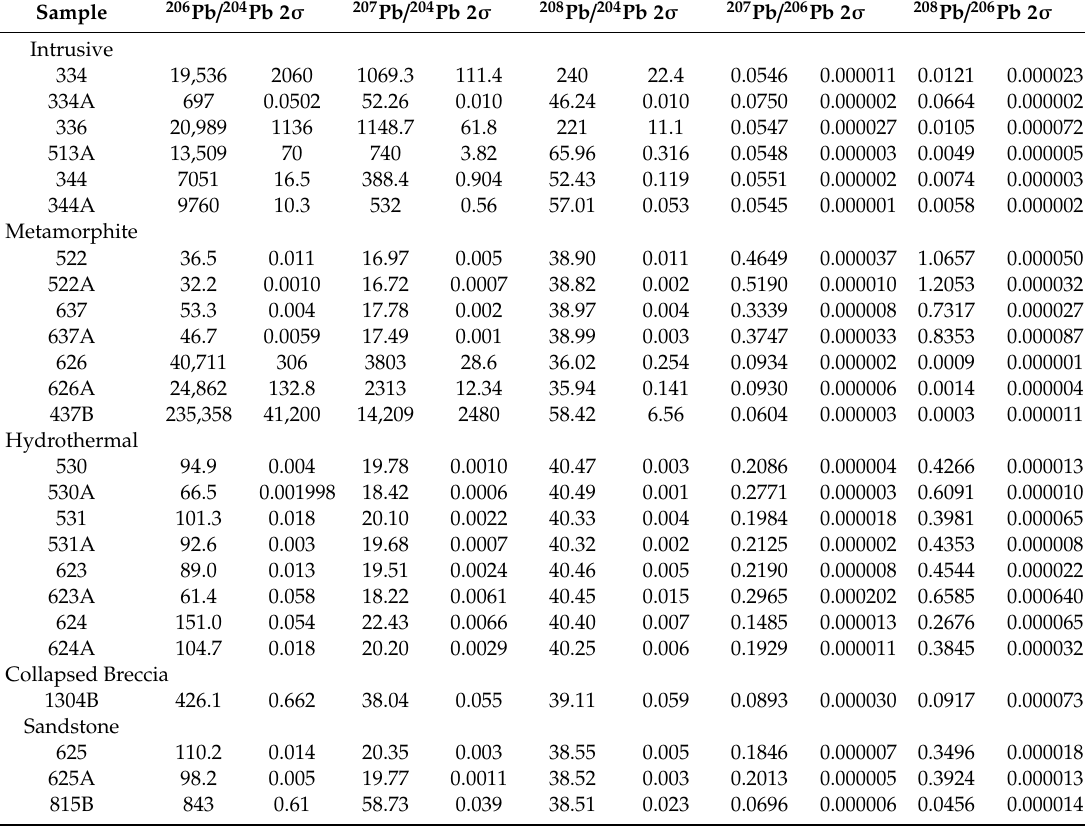
Table 3. Isotopic Pb ratios determined by solution mode (SM) multicollector (MC)